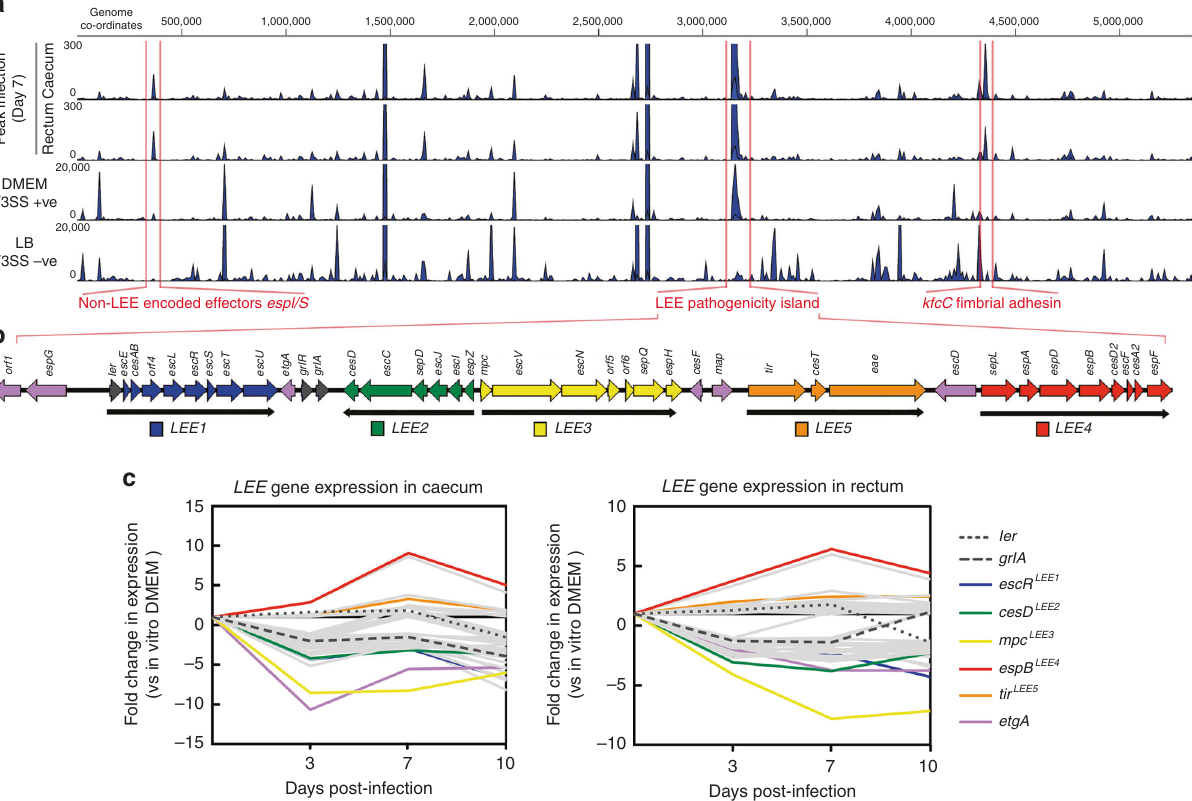
Fig. 2 Dynamics of C. rodentium virulence gene expression in vivo. a Genome-wide coverage plots of RNA-seq data mapped uniquely to the C. rodentium reference indicating transcript levels in vivo. Data are representative of peak infection (day 7) and control conditions (T3SS + ve/ − ve) with the relative scale indicated on the left. Regions of interest relating to virulence determinants are highlighted in red. b Expanded schematic illustration of the LEE pathogenicity island with each operon ( LEE1 – LEE5 ) colour coded. Regulator encoding genes ( ler and grlRA ) as well as LEE genes not encoded in operons are indicated in black or purple respectively. c Expression dynamics of the LEE in vivo compared to in vitro growth in DMEM. The line plots illustrate fold- change in expression at each site and time point during infection. Genes representing the highest fold change for each operon are colour coded according to panel 2b (and labelled in parentheses) while remaining LEE genes are illustrated in grey. Gene expression data represent the mean of three replicates in all cases and full expression heatmaps are found in Supplementary Figure